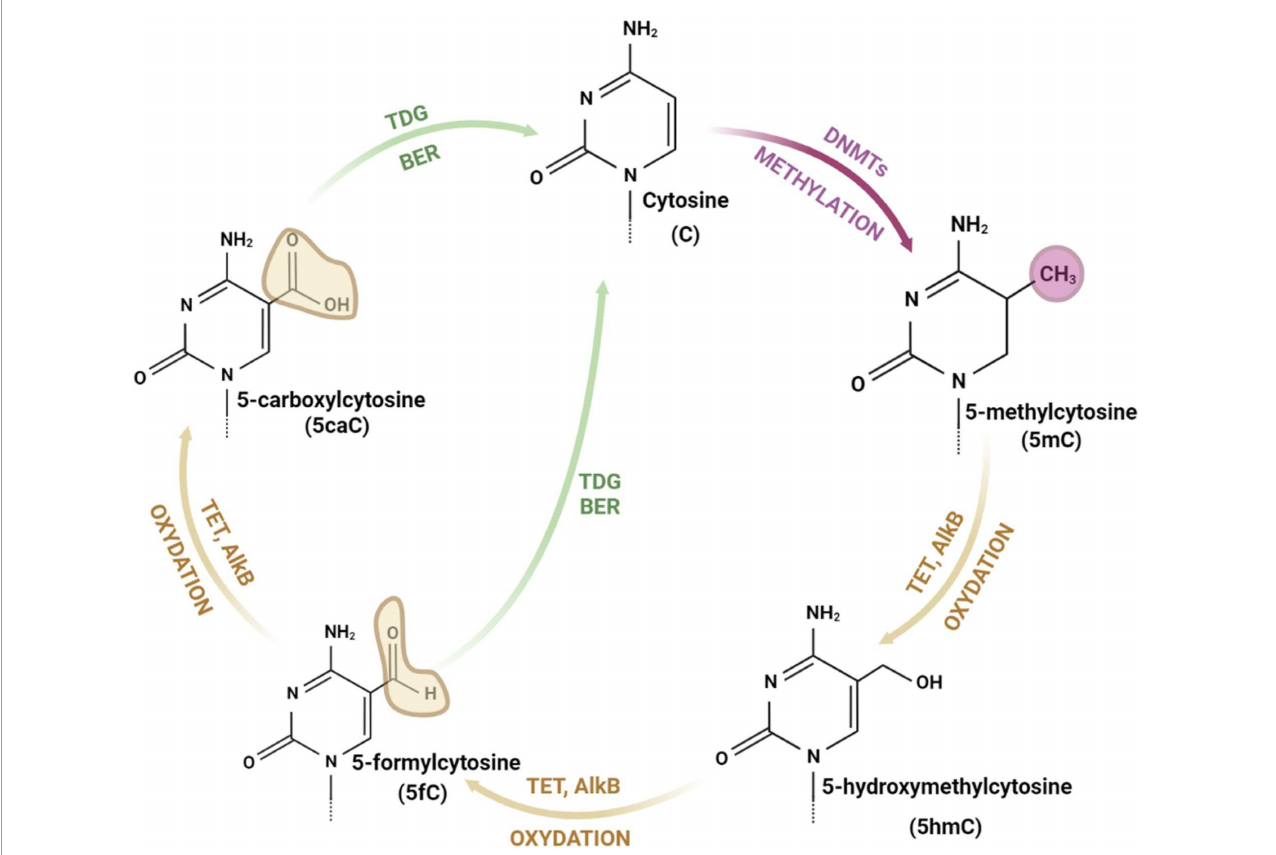
FIGURE1 The cycle of cytosine modifications. The cytosine is methylated by DNA methyltransferases (DNMTs) and demethylated through iterative stages of cytosine oxidation (with 5-hydroxymethylcytosine, 5-formylcytosine and 5-carboxylcytosine as intermediate forms) catalyzed by ten-eleven translocation enzymes (TETs), alpha-ketoglutarate dependent dioxygenases (AlkB), thymine DNA glycosylase (TDG), and base excision repair (BER) pathway. drawings are made in BioRender.com.